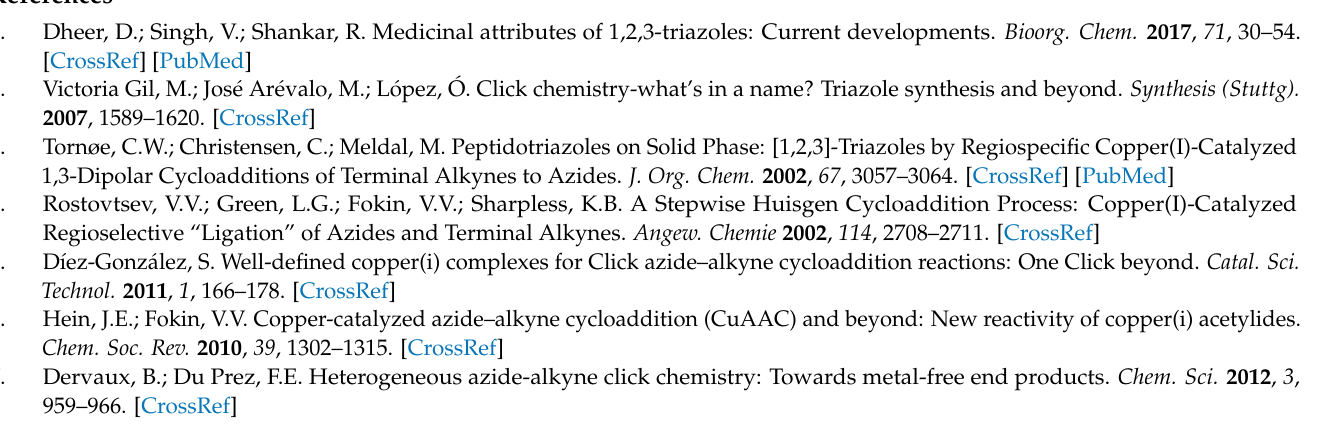
Figure S4: FTIR spectrum of 1-benzyl-4-phenyl-1H-1,2,3-triazole, Figure S5: FTIR spectrum of triazole, Figure S7: FTIR spectrum of CNT-ox-Na support (2000-400 cm − 1 ), Figure S8: FTIR spectrum of 2 _CNT-ox-Na (2000-400 cm-1), Figure S9: FTIR spectrum of 4 _CNT-ox-Na (2000-400 cm − 1 ), Figure S10: Coordination at the Cu centre through a carboxylate group upon replacement of an iodo ligand, Figure S11: Coordination at the Cu centre through a carboxylate or a phenolate group, Figure